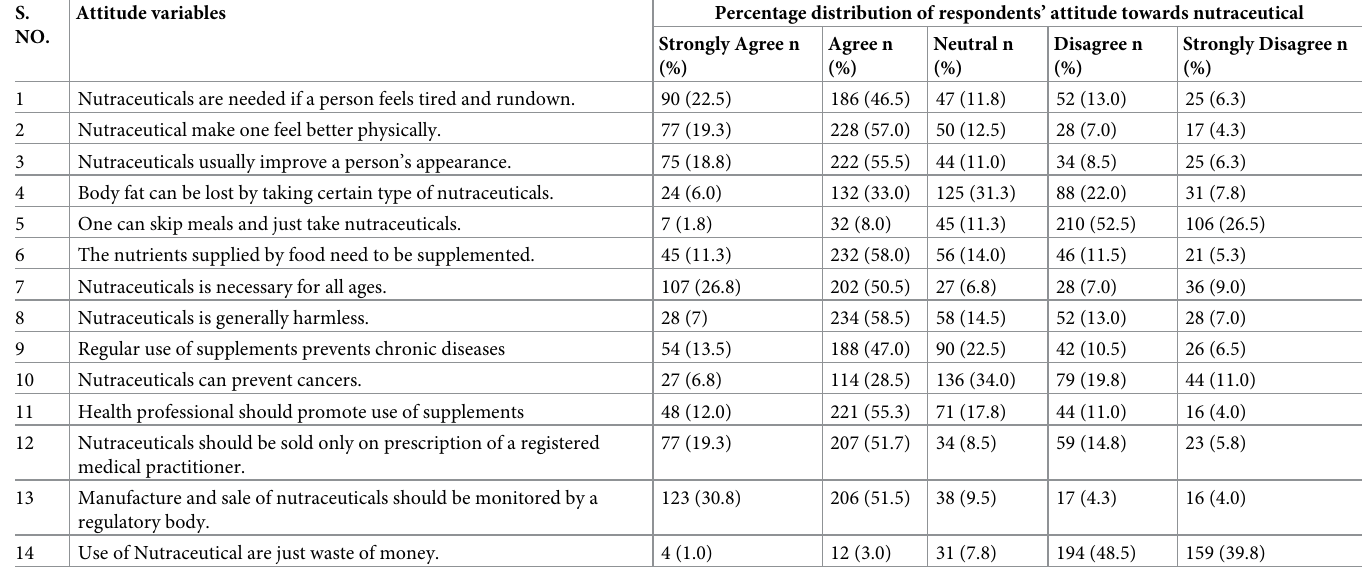
Table 4. Percentage distribution of respondents’ attitude towards